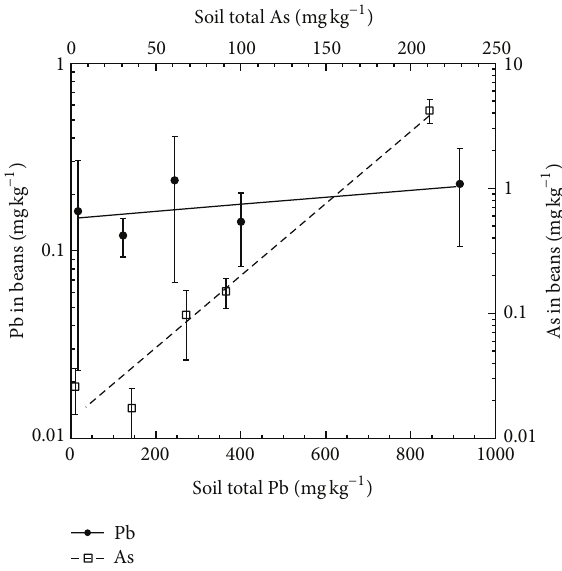
Figure 4: Pb and As concentrations (mgkg −1 d.w.) in green bean pods grown on orchard soils containing a range of Pb and As concentrations.